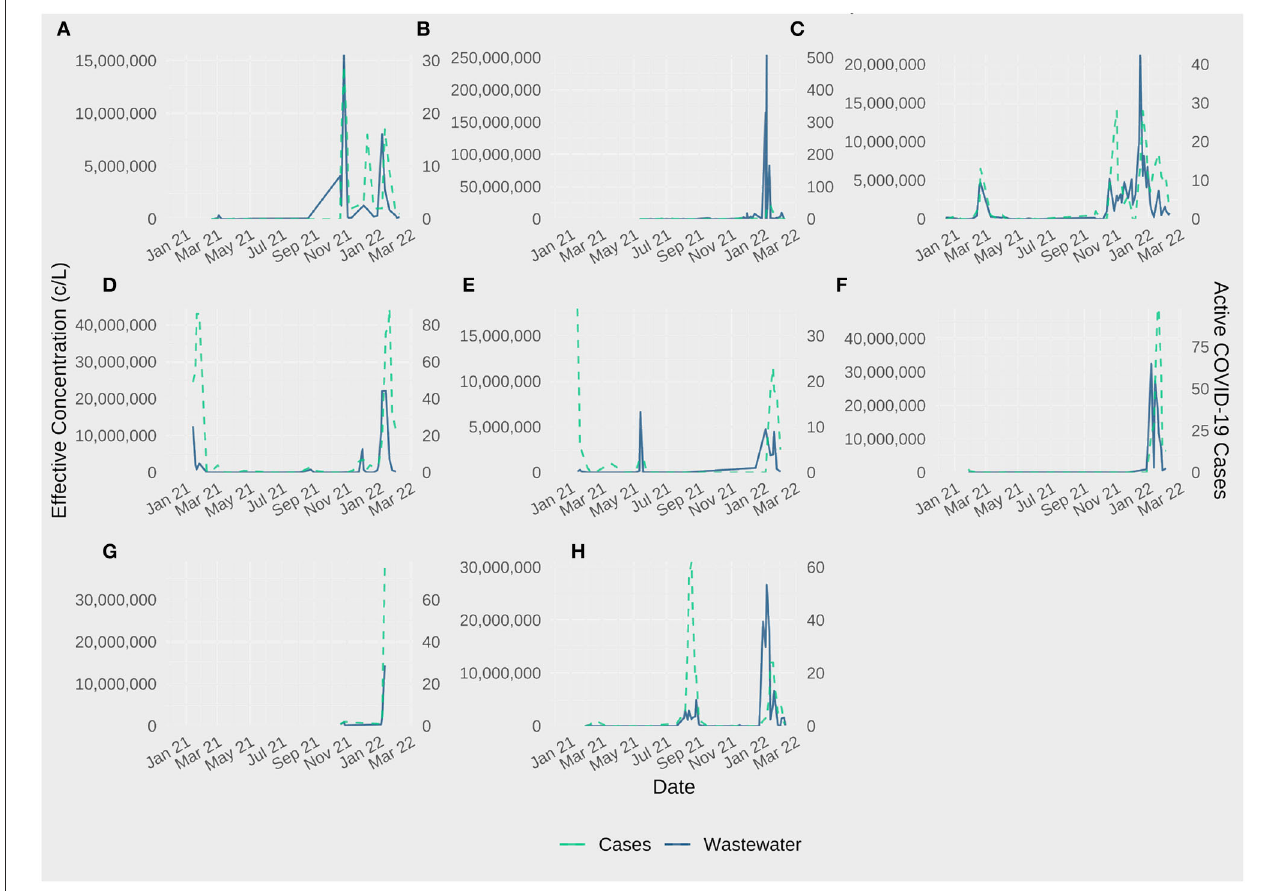
FIGURE2 Effective SARS-CoV-2 concentration and active resident COVID-19 cases in Eight Massachusetts Department of Corrections Facilities (A–H) , December 2020–February